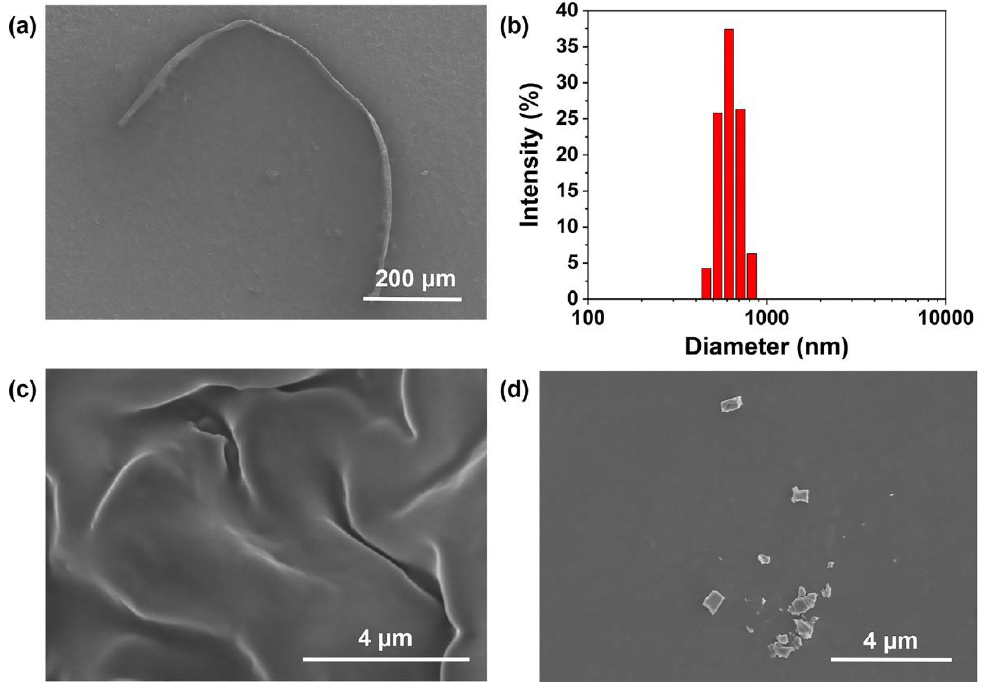
Figure 4. ( a ) SEM image and ( b ) hydrodynamic size of p(P[5](OTf) 2 - co -9,10-dea) in THF, [pil- lar[5]arene unit] = 10 −5 M. ( c ) SEM image of p(P[5](OTf) 2 - co -9,10-dea) in THF ([pillar[5]arene unit] = 10 −3 M) and ( d ) adiponitrile and p(P[5](OTf) 2 - co -9,10-dea) in THF ([pillar[5]arene unit]: [adiponitrile] = 1:10).